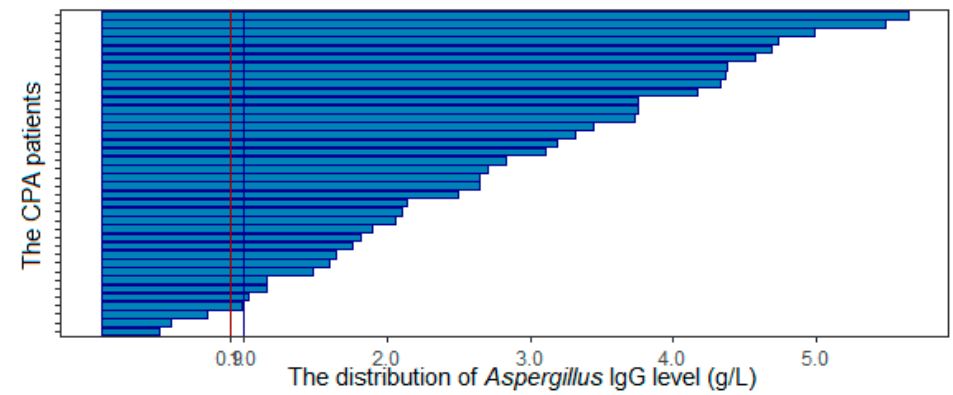
Figure 1. Summary of Aspergillus IgG distribution.